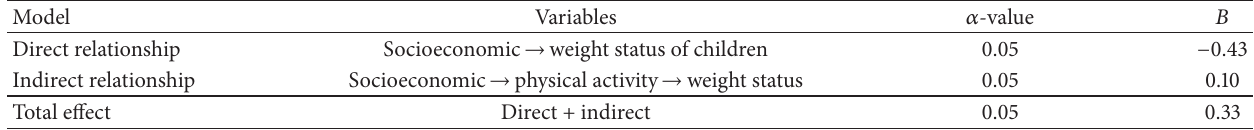
Table 9: Socioeconomic status related to weight status of children (through physical activity).